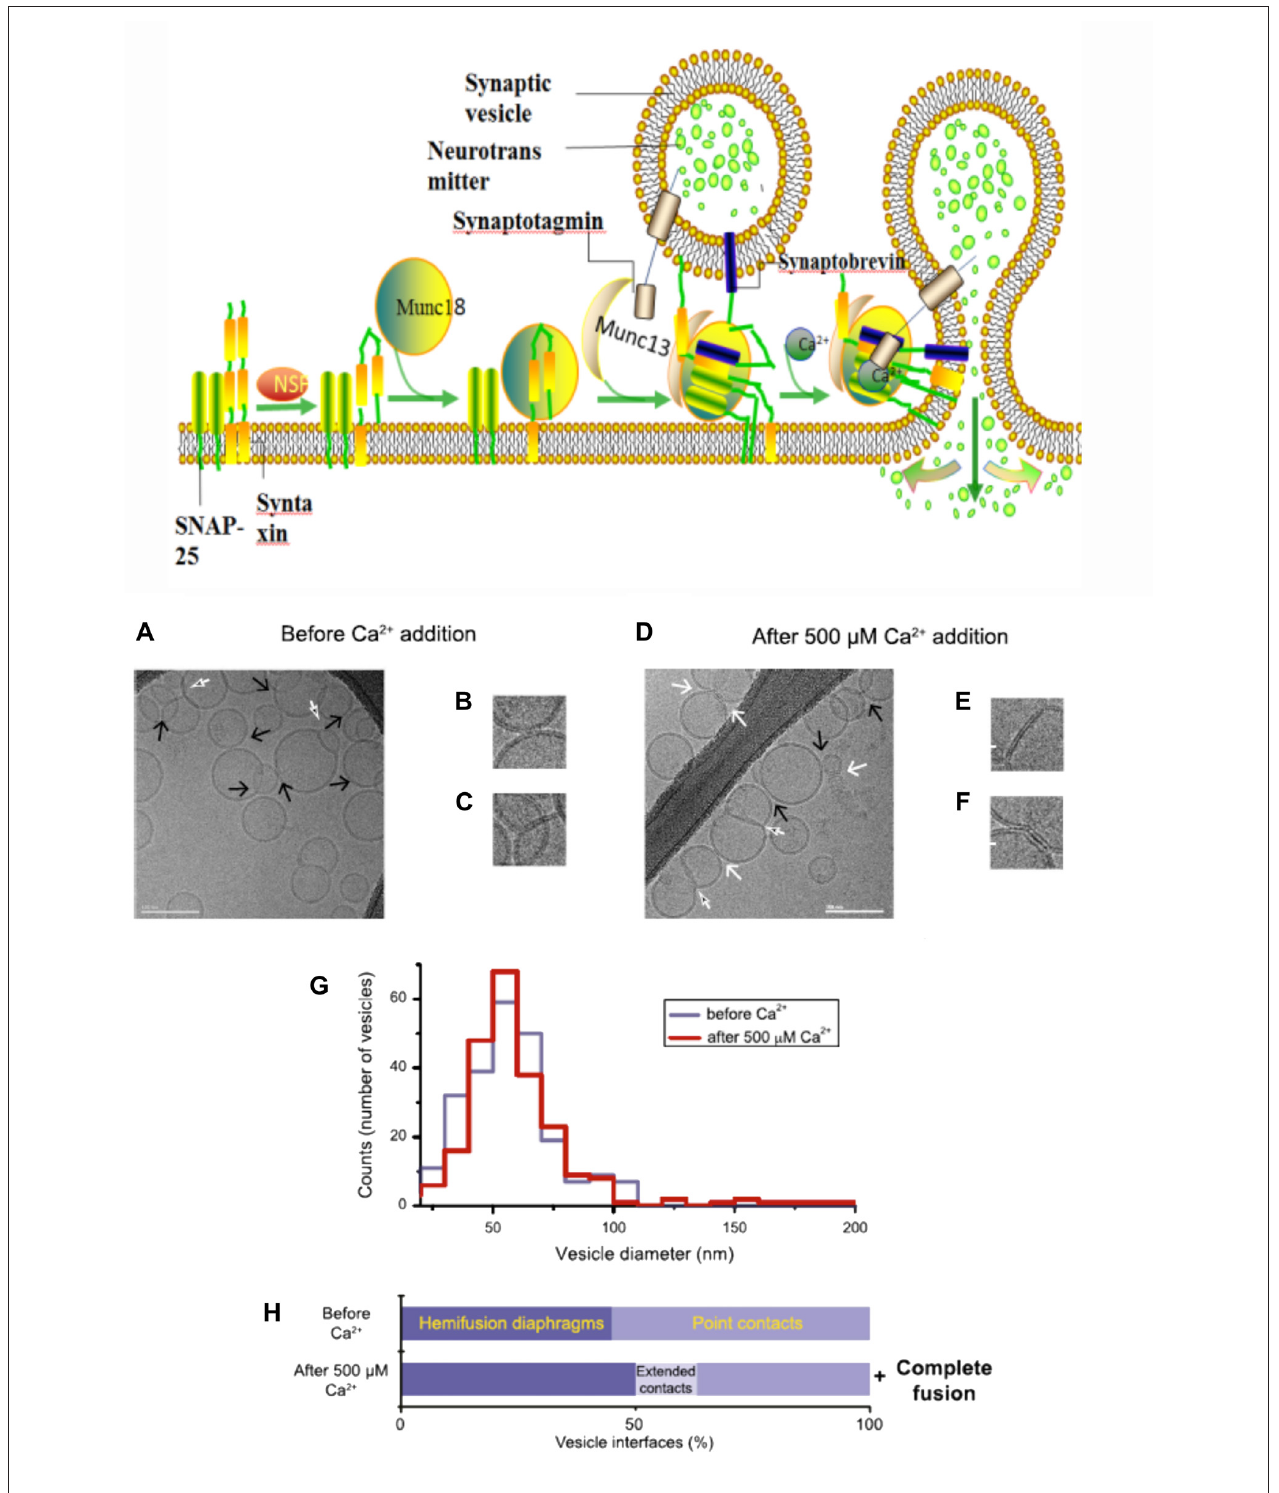
FIGURE 2 | A model with Muncs (Upside) the Soluble N-ethylmaleimidesensitive factor attachment protein receptor (SNARE) complex, fused by v-liposomes (containing synaptobrevin) and t-liposomes (containing SNAP-25 and syntaxin), was disassembly derived under the N-ethylmaleimide–sensitive factor (NSF) with the consuming of adenosine triphosphate (ATP). The entry of Munc18-bound syntaxin into SNARE complexes was catalyzed by Munc13, with the assembly of ternary v/t-SNARE complexes. Then Synaptotagmin-Ca 2 + induce the release of neurotransmitter, thereby drive membrane fusion. Imaging of donor/acceptor interface morphologies by cryo-electron microscopy (EM) before and after Ca 2 + addition (Downside; Diao et al., 2012).